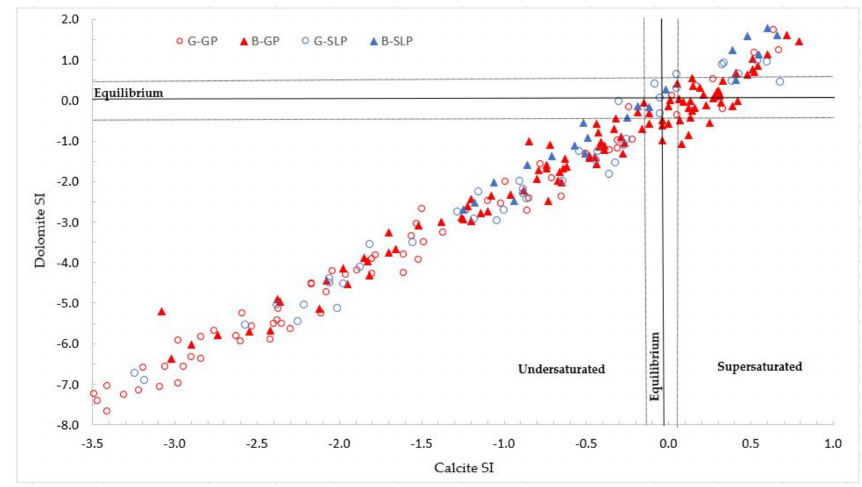
Figure 6. The calcite saturation index (SI) vs. dolomite SI. GP, Grenville Province; SLP, St. Lawrence Platform; G: granular aquifer; B: bedrock aquifer.